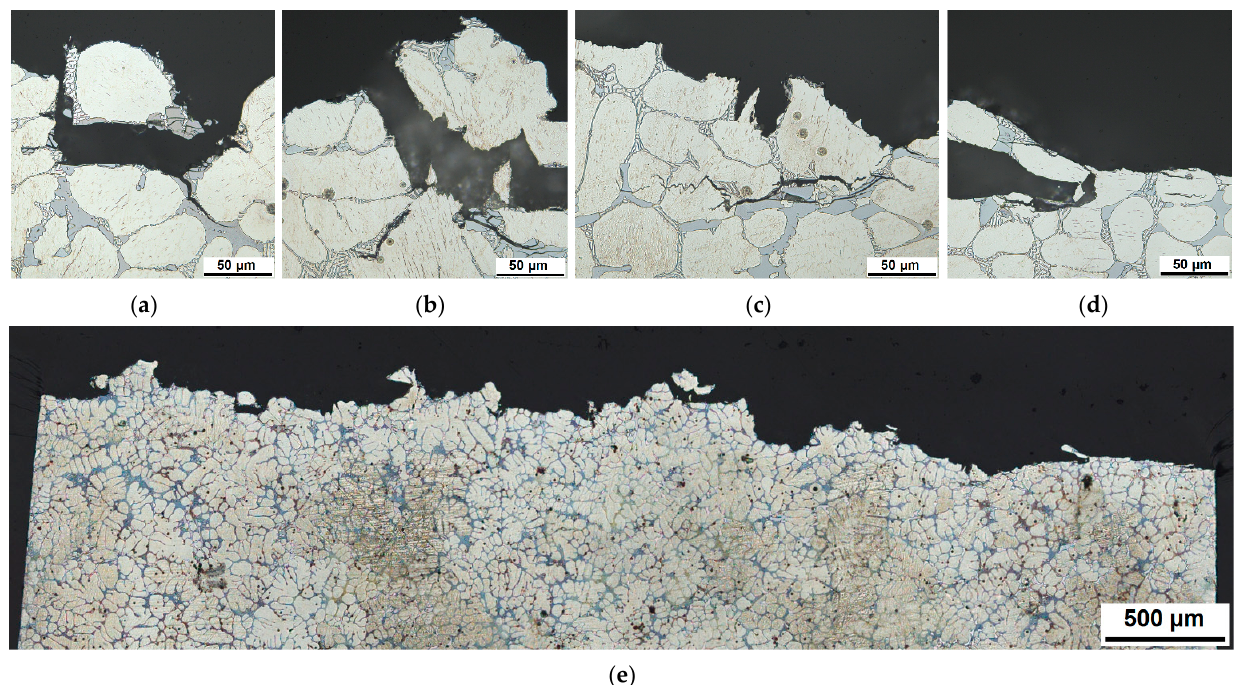
Figure 6. Cross-sectional micrographs of fracture surface after fatigue load (R = 0, 43,000 cycles) showing the crack propagation of the sub-cracks near the main crack and its interaction with the microstructural features ( a – e ).